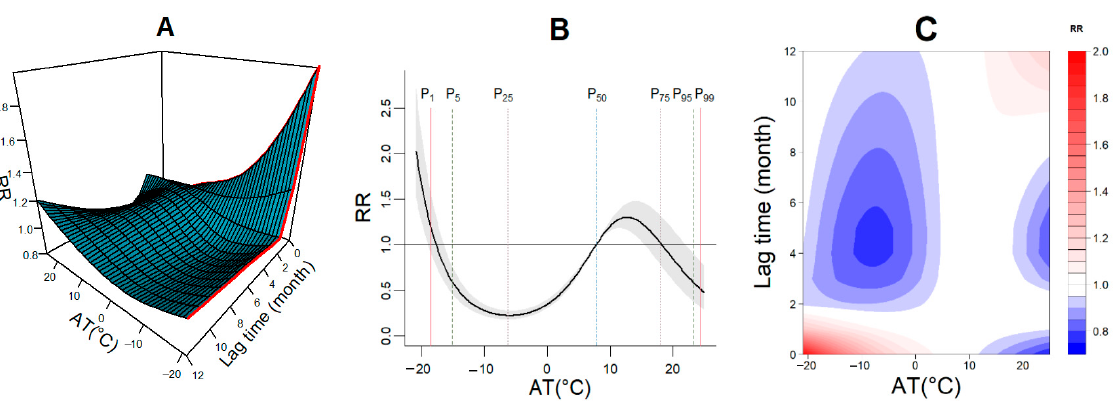
Figure 4. The exposure-lag-response correlations between meteorological factors and the incidence of PTB in Xinjiang from 2004 to 2019. ( A ) represents the 3–D graph of the relationship between AT and PTB incidence, ( B ) represents the overall cumulative relative risk of AT on PTB incidence across lag 0–12 months, ( C ) represents the heatmap of AT on PTB incidence.